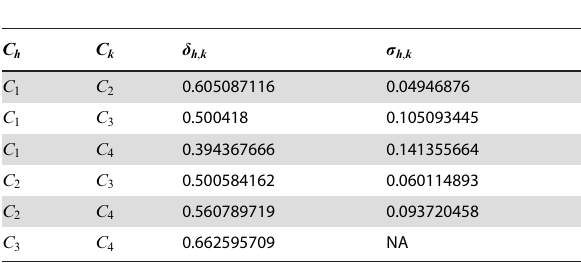
Table 8. Average distance between the NetSel extracted communities and relative standard